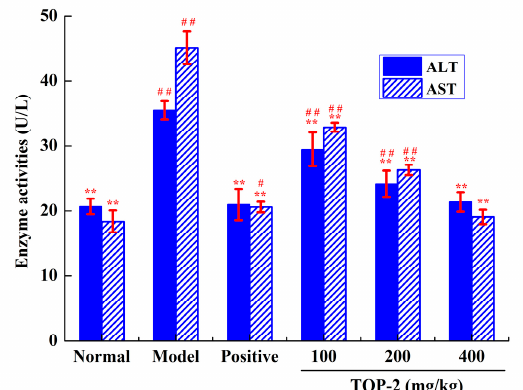
Figure 3. Effects of TOP-2 on serum ALT and AST levels in alcohol-induced liver injury mice. Results are represented as means ± SD ( n = 10). ** p < 0.01, by contrast with model control; # p < 0.05 and ## p < 0.01, by contrast with normal control.